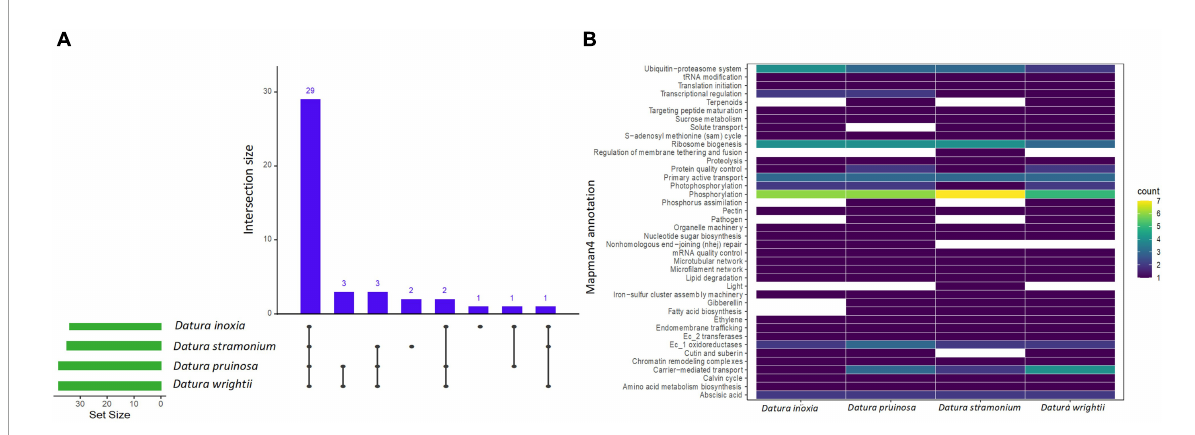
FIGURE4 UpSet plot shows the intersections of the set of a particular protein family annotated with Mapman4 with signal of positive selection from the seven transcriptomes. Filled cells indicate that the set is participating in the intersection and that the species share that protein family with signal of positive selection (A) . Heatmap of the enriched proteins with signal of positive selection of the four Datura species studied here (B) . The brightness of color indicates the number (counts) of enriched protein families with signal of positive selection that are shared between species. See also Supplementary Table 6